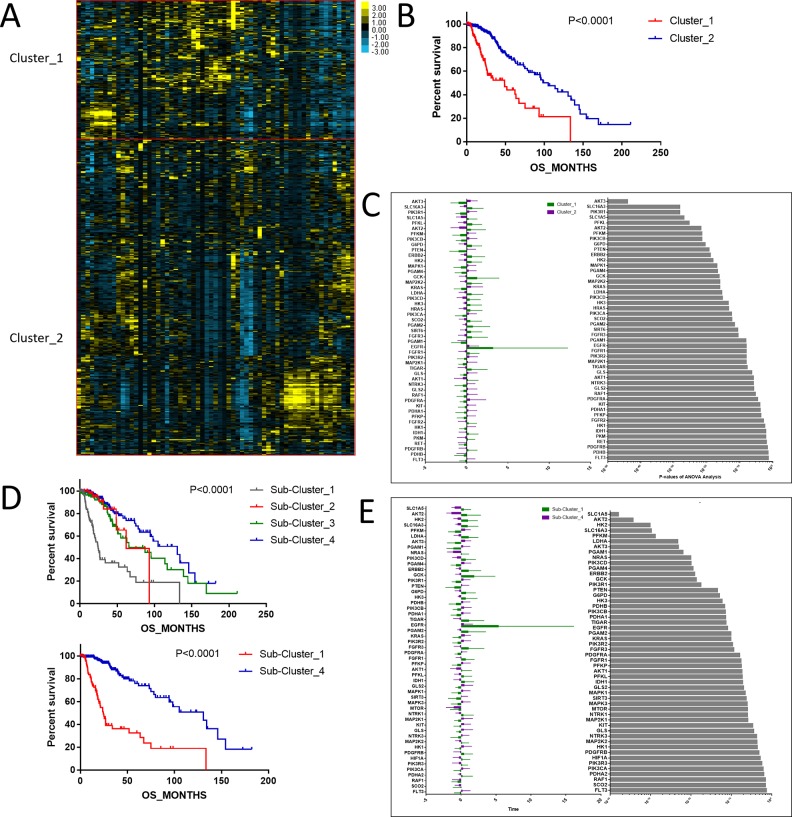
The expression profile of central carbon metabolism–associated genes in glioma patients. (A) In total, 514 patients were primarily divided into two clusters. The expression values of 63 genes corresponding to the individual patient were arrayed in the columns according to the expression affinity. Patients with similar gene expression patterns were clustered and grouped using the hierarchical clustering algorithm and arrayed in the rows. (B) The patients in cluster 1 had much worse prognoses than the patients in cluster 2, of which overall survival (OS) was 48.65 months compared to 105.12 months. (C) There were 49 genes that showed a significant difference in the expression levels between the two clusters P < 0.05. (D) The studied cohort was further subdivided into four subclusters, among which the subcluster 1 was with the worst OS and subcluster 4 showed the most favorable outcome. (E) The differential expression analysis revealed that 52 metabolism-associated genes were significantly different between subcluster 1 and subcluster 4.